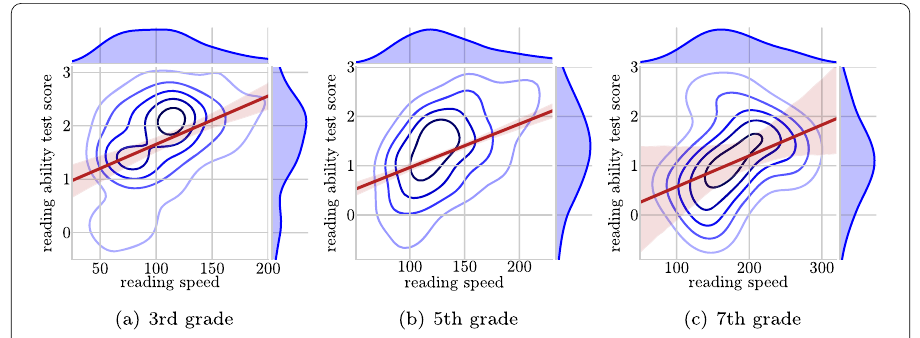
Figure 1 Kernel density plots, predicted line and confidence intervals for the relationship between average reading speed and reading ability test scores on the cleaned data. Grades three, five and seven. Reading speed from September through November 2019. Reading ability test scores from April 2019.